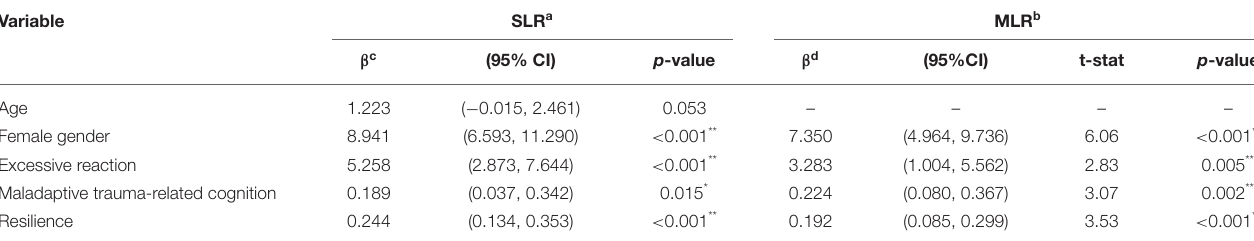
TABLE 4 | Predictors of PTS